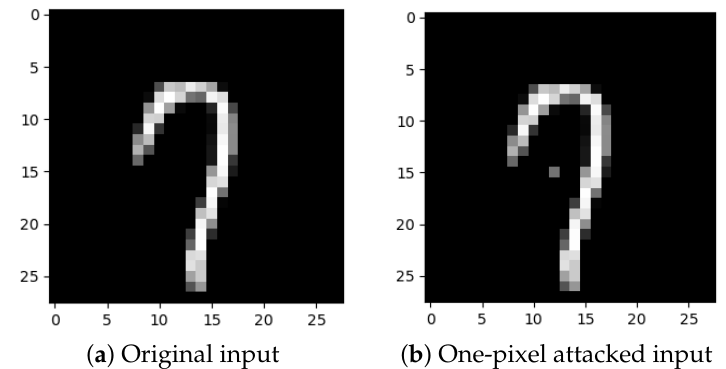
Figure 1. Example of a one-pixel